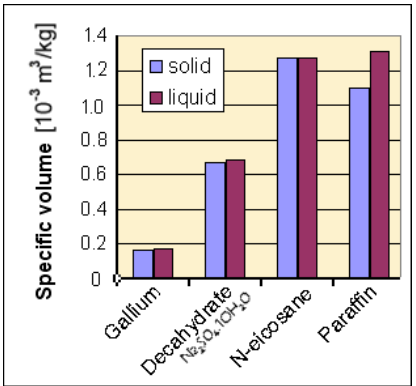
Fig. 10. Also of considerable importance in designing the latent heat storage system are the specific volumes of the materials – and the changes that the volume undergoes in the melting and solidification. The typical larger value of the liquid phase means the solid body, instead of floating (like ice) on the liquid surface, would be kept at the bottom of the storage vessel. Values in the diagram are valid for T ~20 o C.